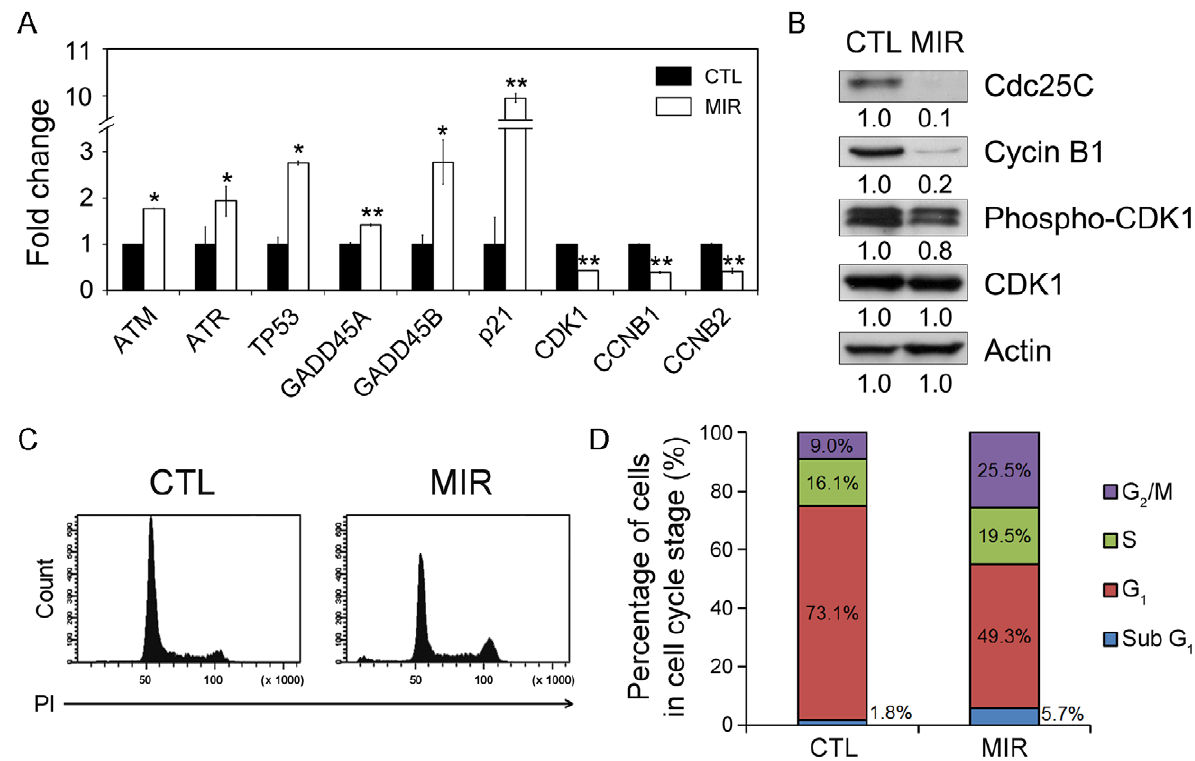
Figure 5. MIR exposure induced G 2 /M cell cycle arrest in A549 cells. Cells were exposed to MIR for 48 h, and harvested for RNA and protein extraction. (A) Gene expression of genes involved in regulation of G 2 /M transition (x-axis). The y-axis indicates the relative transcript quantities calculated using the DD Ct method with GAPDH as the reference gene amplified from each sample. The data are presented as mean 6 S.D. ( n =3). * P , 0.05, ** P , 0.001. (B) Protein expression levels were examined by Western blot with actin as the internal control. All experiments were repeated three times. (C) Flow cytometric analysis of DNA content. Cells were exposed to MIR for 48 h. Cells from six independent experiments were collected for analyzing cell cycle distribution. (D) The percentage of cells in each phase was obtained by MultiCycle analysis.